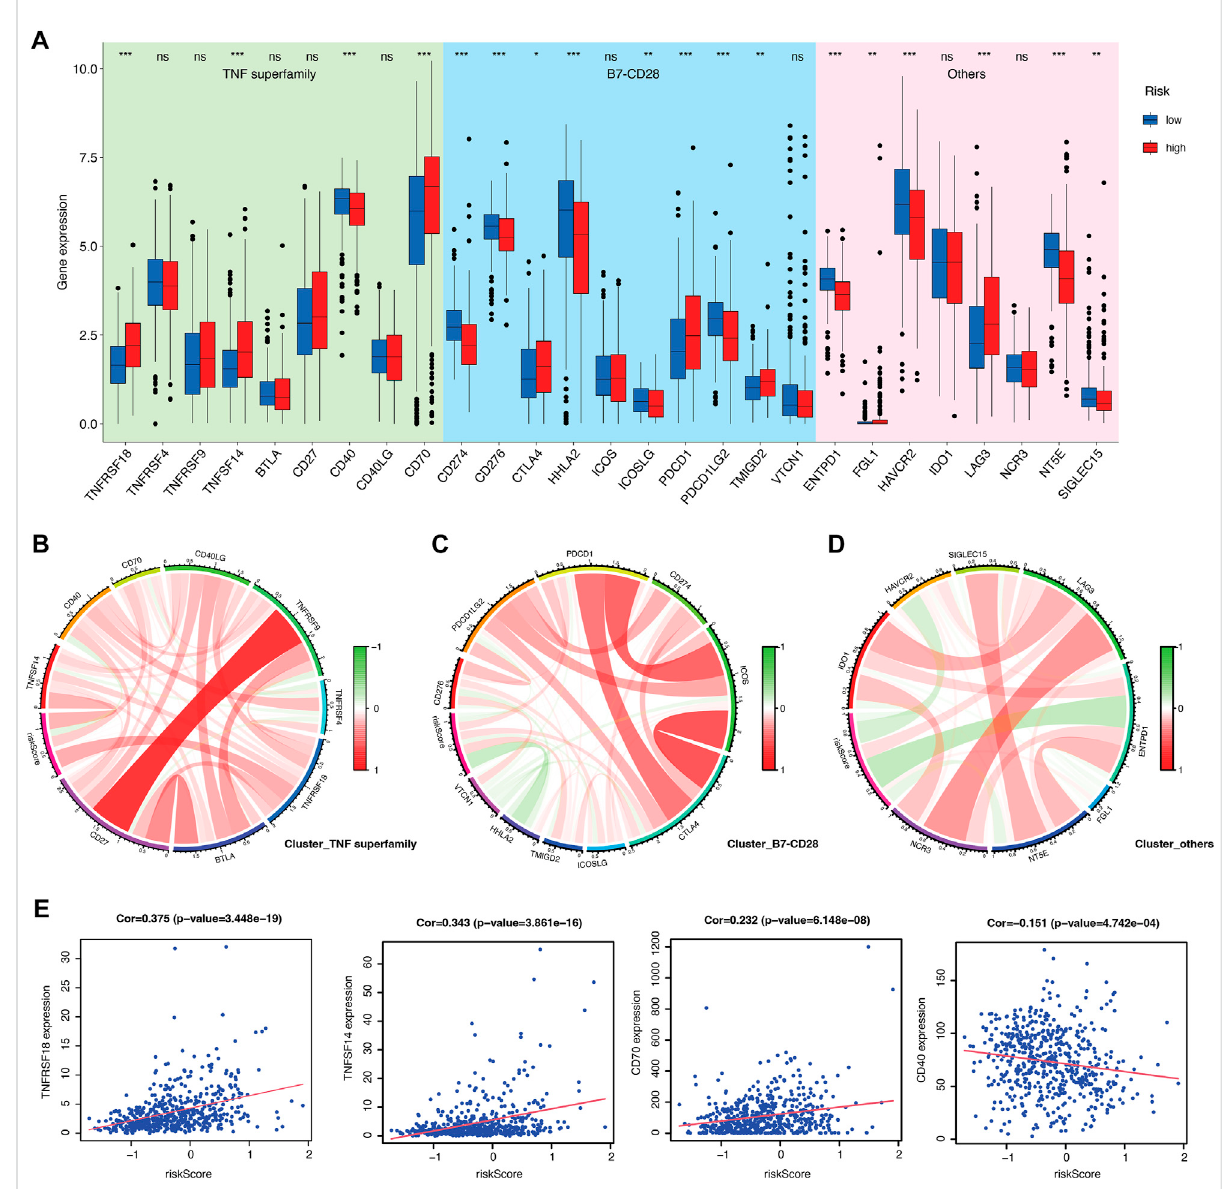
FIGURE 6 Evaluation of immune checkpoints between CRGs-related risk subtypes. (A) Gene expression of immune checkpoints between CRGs-related risksubtypes. (B – D) CorrelationofimmunecheckpointmembersofTNFsuperfamily (B) ,B7-CD28superfamily (C) ,andothers (D) . (E) Thecorrelation of speci fi c immune checkpoint members with risk